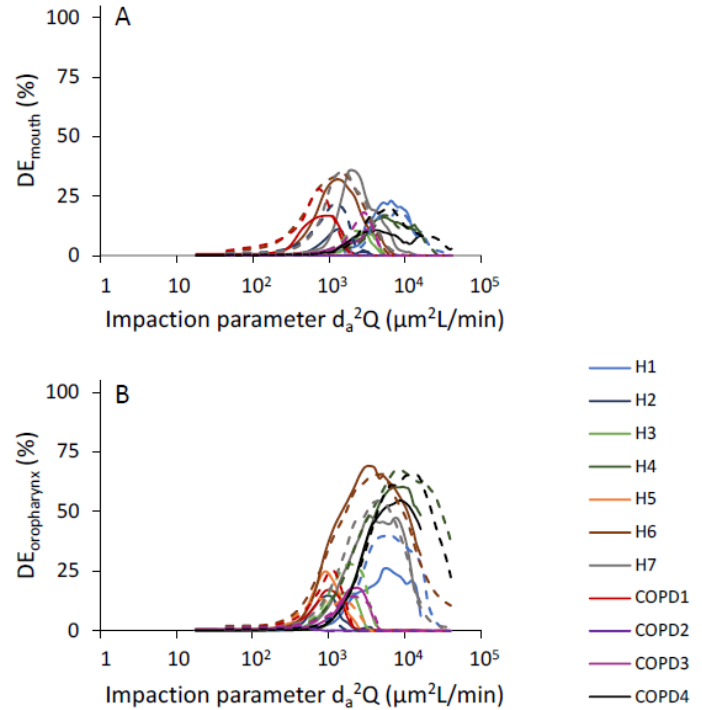
( A , D ), middle ( B , E ) and lower panels ( C , F ), respectively. Deposition at a flow rate of 18 L/min and 45 L/min are shown in the left ( A – C ) and right panels ( D – F ), respectively. Note the y-axis range differs for each particle size.